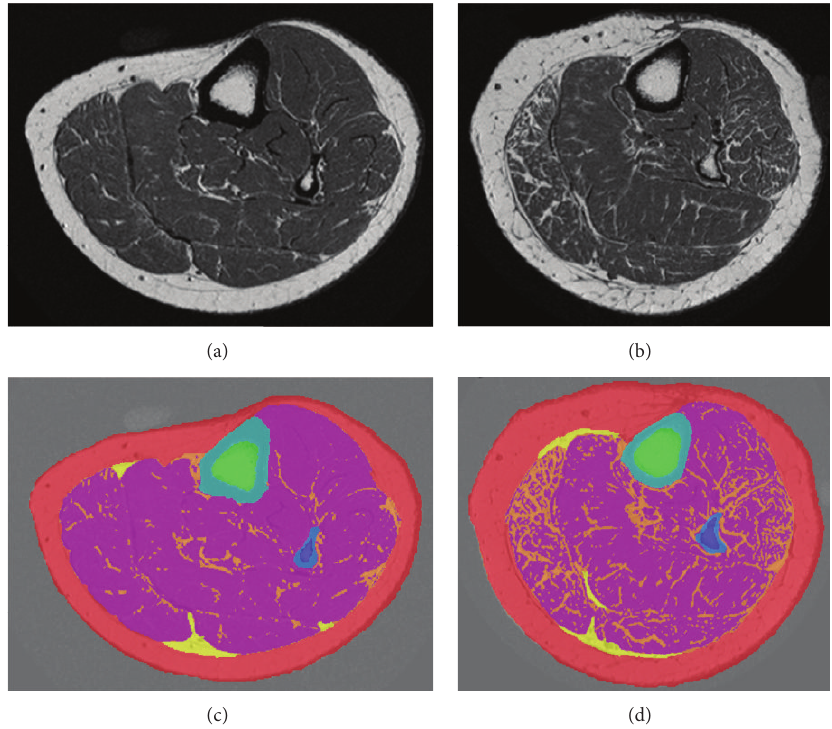
Figure 1: Axial MRI images of the lower leg from a Caucasian postmenopausal woman without type 2 diabetes (age 68 years, percent IntraMAT = 8%) (a) and with type 2 diabetes (age 67 years, percent IntraMAT = 14%) (b). Segmented images of the lower leg from the participant without type 2 diabetes (c) and with type 2 diabetes (d). Subcutaneous adipose tissue (red), muscle (fuchsia), intermuscular adipose tissue (InterMAT) (yellow), intramuscular adipose tissue (IntraMAT) (orange), tibia cortical bone (blue), tibia bone marrow (green), fibula cortical bone (royal blue), and fibula bone marrow